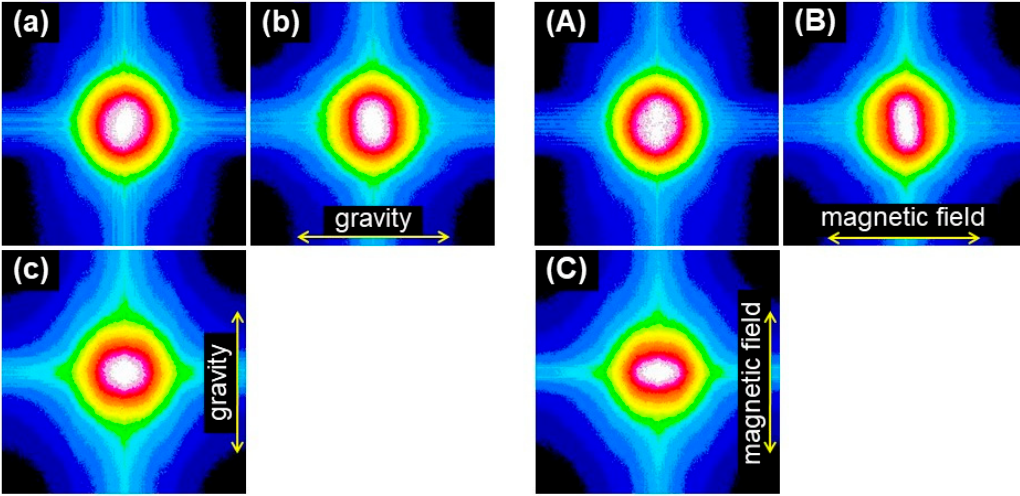
Figure 5. FFT images of CT photographs for magnetic elastomers with different views, ( a, A ) top, ( b, B ) side, and ( c, C ) front view. The direction of gravity and the magnetic field are indicated by arrows. (CI 70 wt%, DOP 70 wt%).